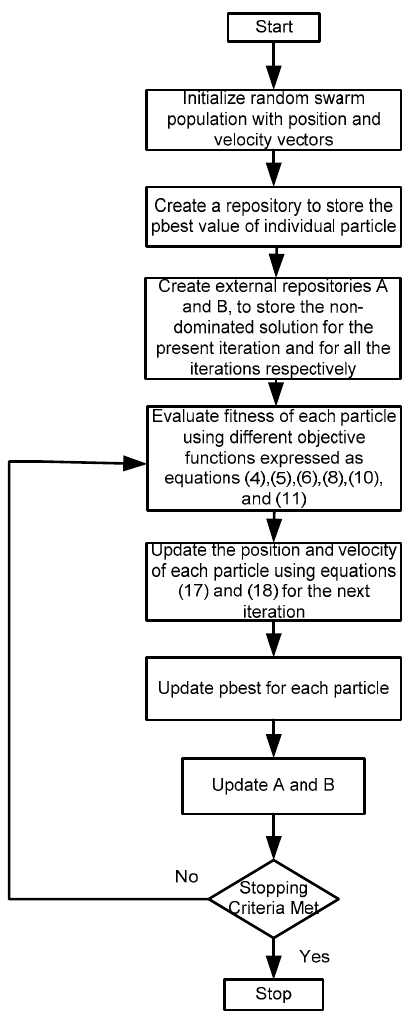
Figure 5. Flow chart for multi-objective particle swarm optimization.